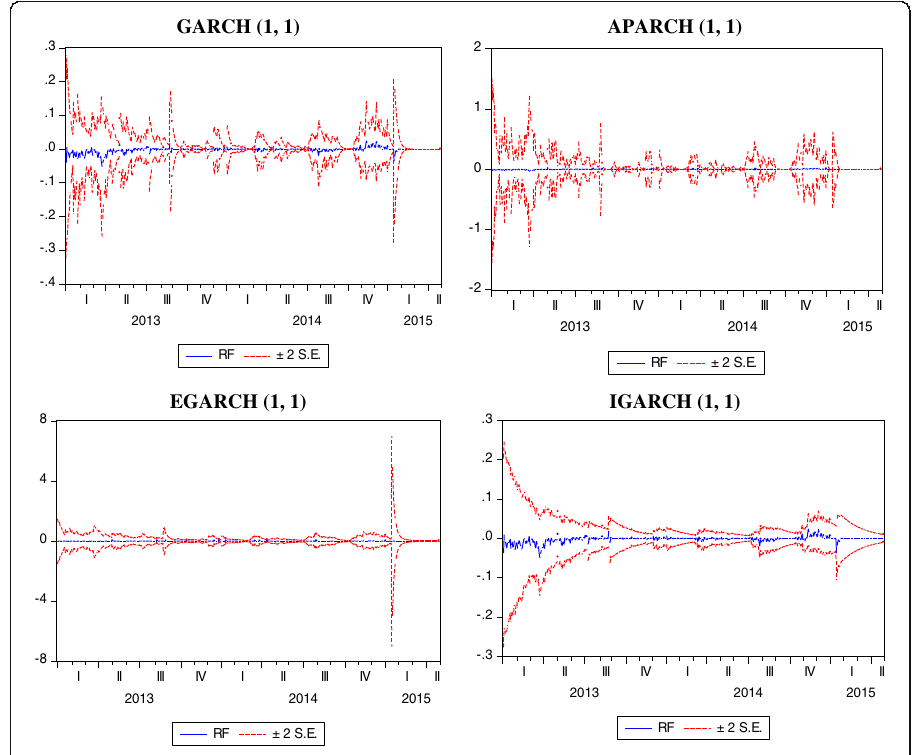
Fig. 5 Volatility forecasting with Student ’ s – t